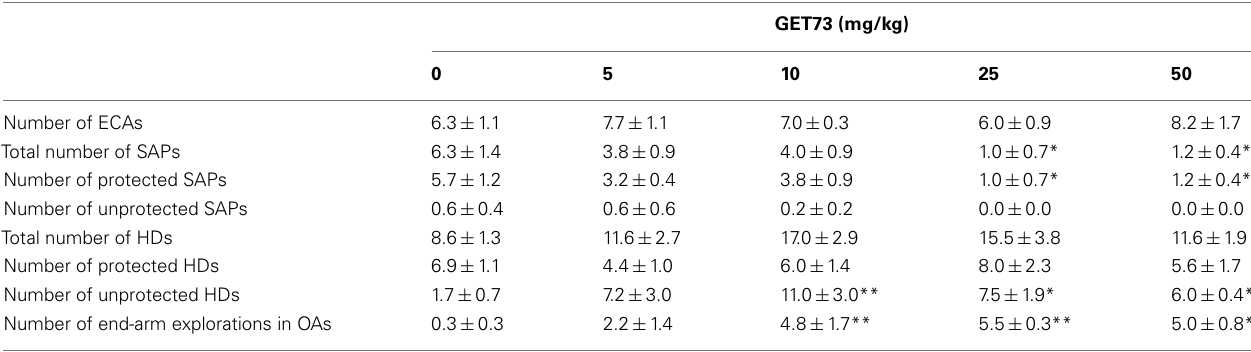
Table 4 | Effect of theacute, intragastric administration of different doses of GET73 on a series of variables measured in Sprague-Dawley rats exposed to the elevated plus maze (EPM)